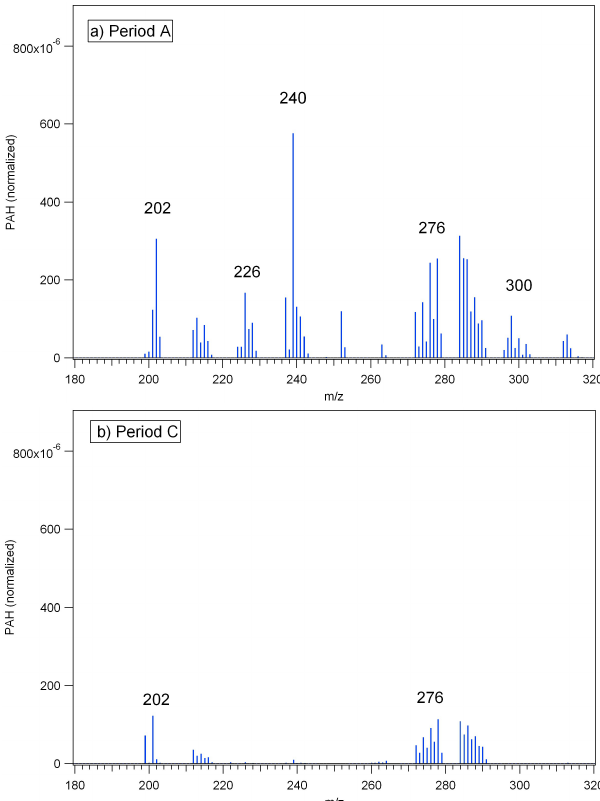
Fig. 3. Average mass spectra of PAHs in 2 different periods: dur- ing the biomass burning event (period A), and a few days after the burning event (Period C); normalized to the sum of the total PAH of both measured periods (A and C). The burning event was averaged over ∼ 7h (12 May 2009), and the a normal day was averaged over 24h (16–17 May 2009).